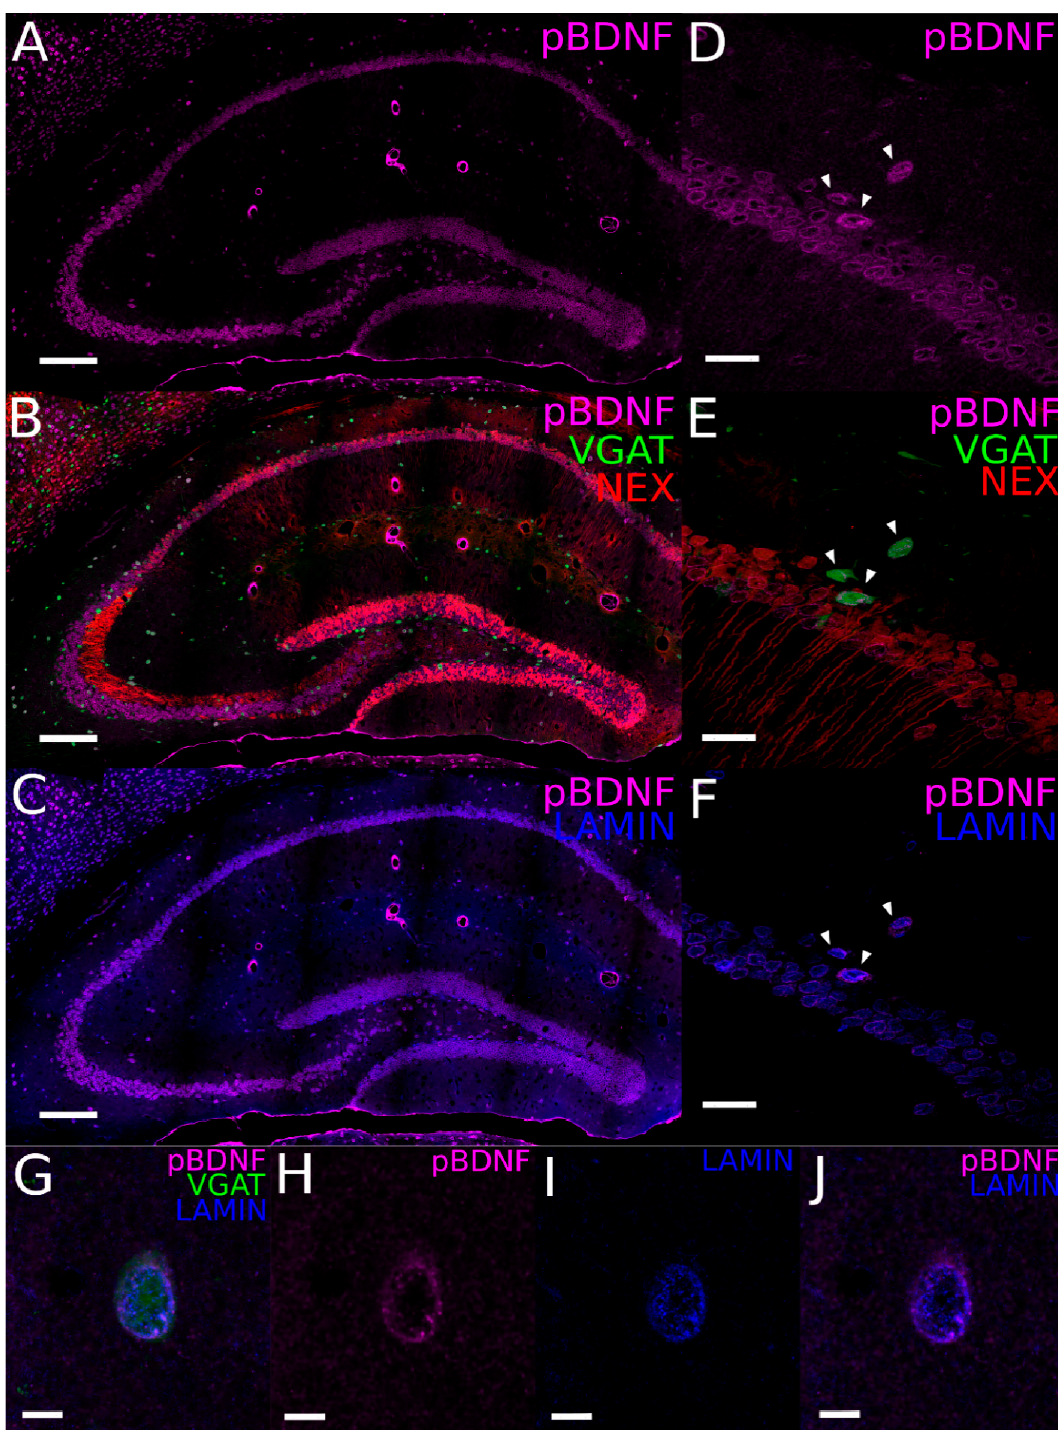
Figure 3. Expression of proBDNF in hippocampal glutamatergic and GABAergic neurons. ( A – C ) Immunostaining for proBDNF (magenta pseudocolor; A,B) and the perinuclear marker, lamin (blue; C) in the hippocampus of VGAT-YFP x NexCre-Ai9 transgenic mice. ( D – F ) High-power confocal images from the hippocampal CA1 area immunolabeled for proBDNF (D,E) and lamin (F). Arrowheads indicate a cluster of YFP-positive GABAergic INs (in green), which are also labeled for proBDNF (D–F). Note that this section is adjacent to the one shown in Figure 2D–F. ( G – J ) High-power confocal images from a hippocampal GABAergic neuron immunolabeled for proBDNF (G,H) and lamin (I,J) (magenta and blue, respectively). Note the perinuclear localization of proBDNF and its colocalization with lamin in (J). Scale bars: (A–C), 200 µ m; (D–F), 30 µ m; (G–J), 10 µ